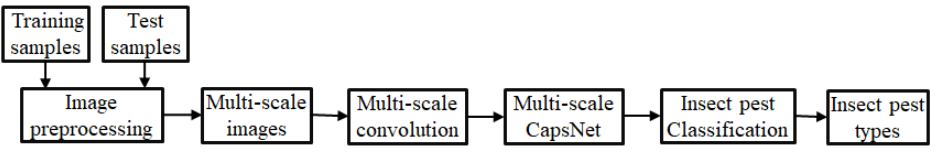
Figure 5. Crop pest recognition process based MSCCN.